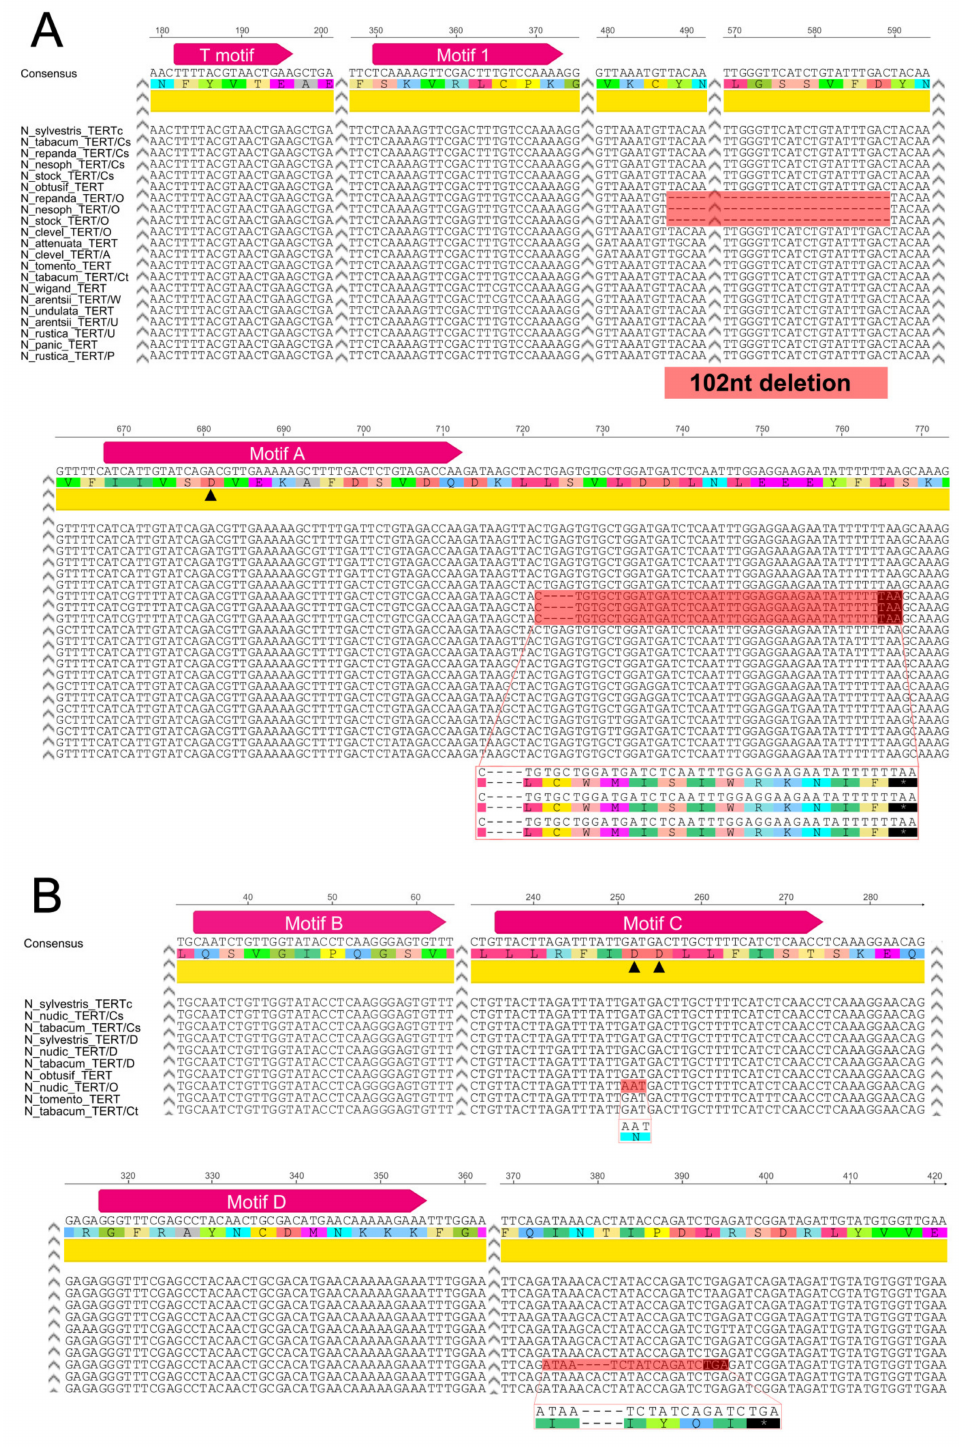
Figure 3. Comparison of TERT variants. ( A ) Alignment of representative TERT variants from Nicotiana polyploids identified here, and previously in N. tabacum [30], clearly illustrates the occurrence of conserved structural motifs, the telomerase